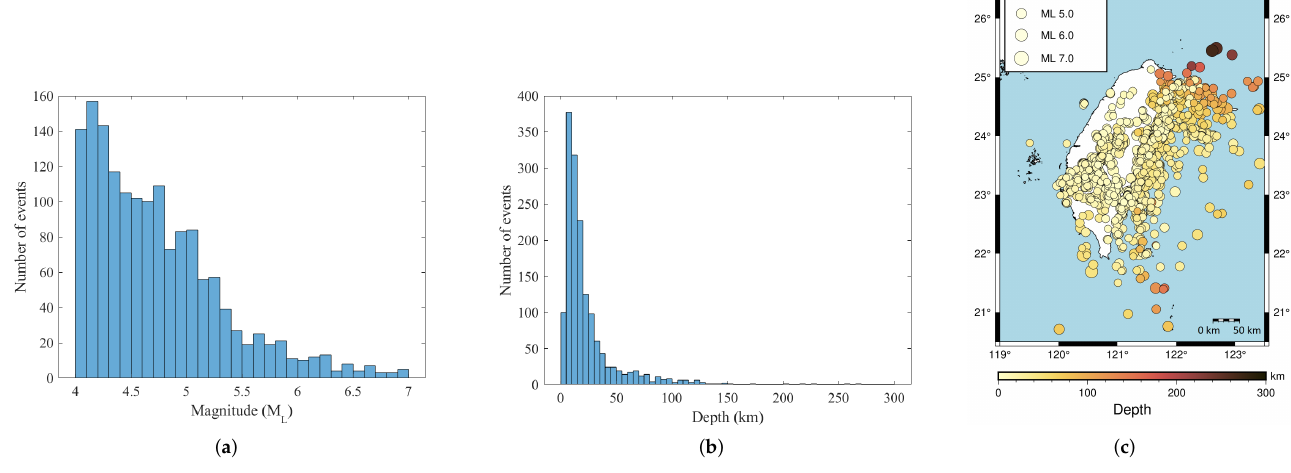
Figure 3. The statistics of the dataset. ( a ) The magnitude histogram. ( b ) The depth histogram. ( c ) The event locations. The size of the circles and the color encode the magnitude and the depth of the corresponding events, respectively.